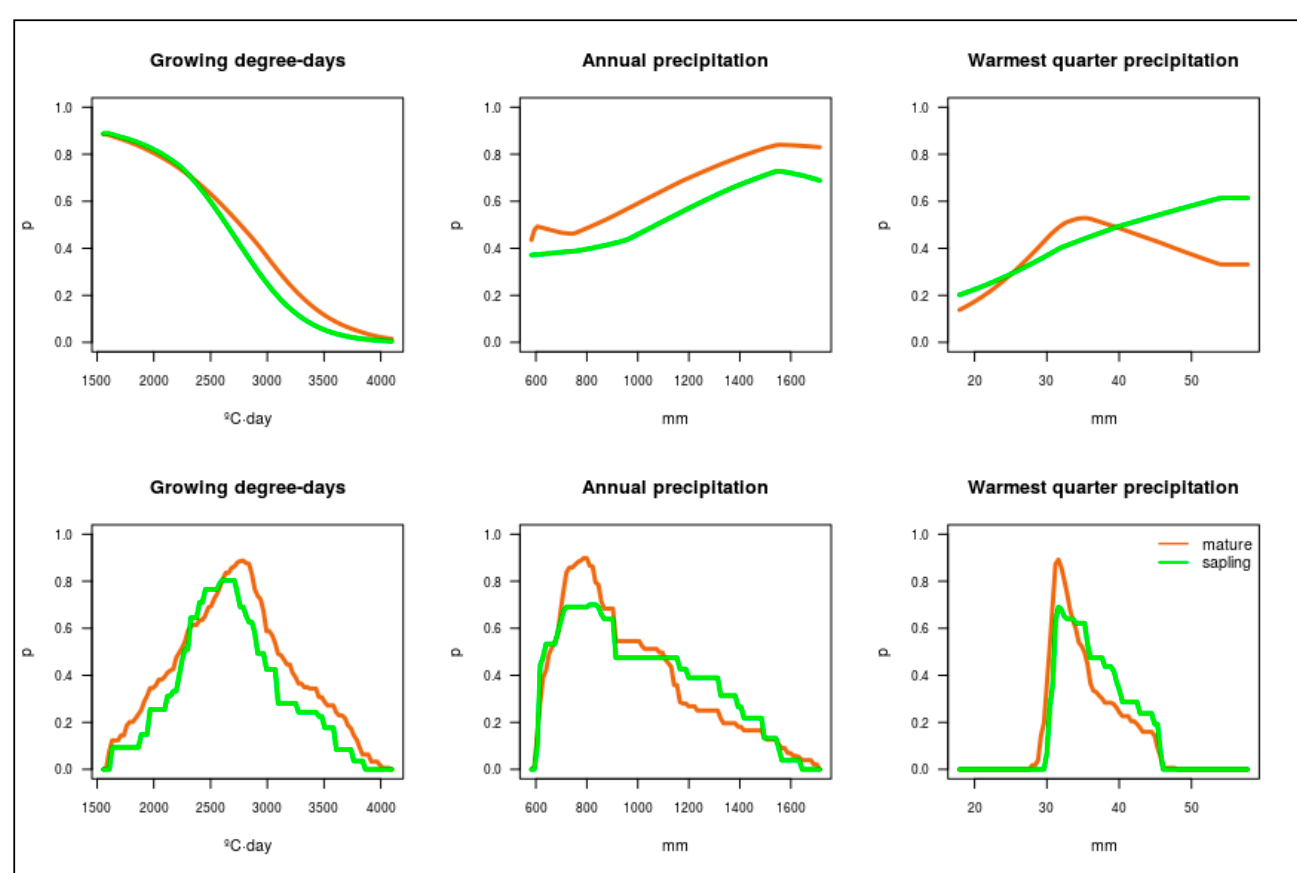
Figure 2. Response curves for the “mature” (brown) and “sapling” (light green) models for the three predictor variables: Growing degree-days, Annual precipitation, and Warmest quarter precipitation (M AX E NT , top ; B IOCLIM , bottom ).